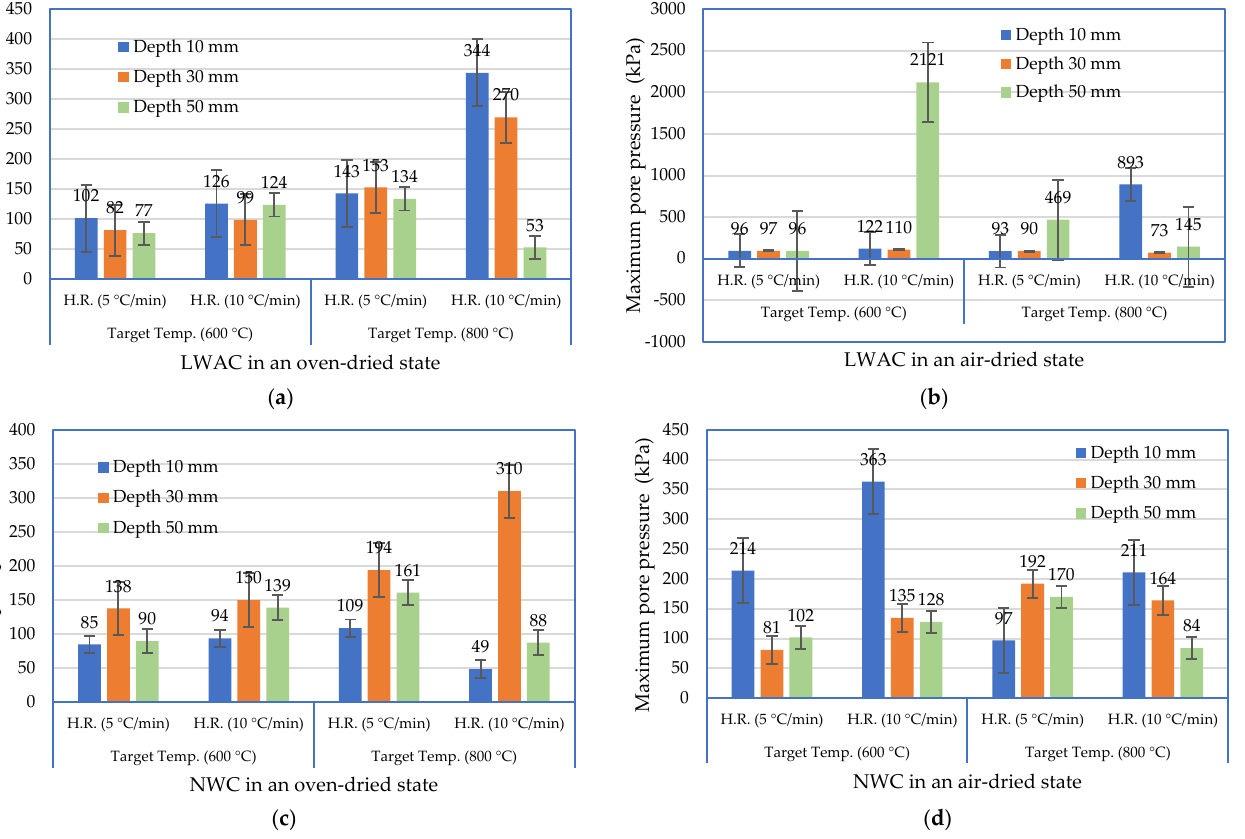
Figure 28. The measured maximum pore pressure under different test conditions: ( a ) LWAC in an oven-dried state; ( b ) LWAC in an air-dried state; ( c ) NWC in an oven-dried state; ( d ) NWC in an air-dried state.